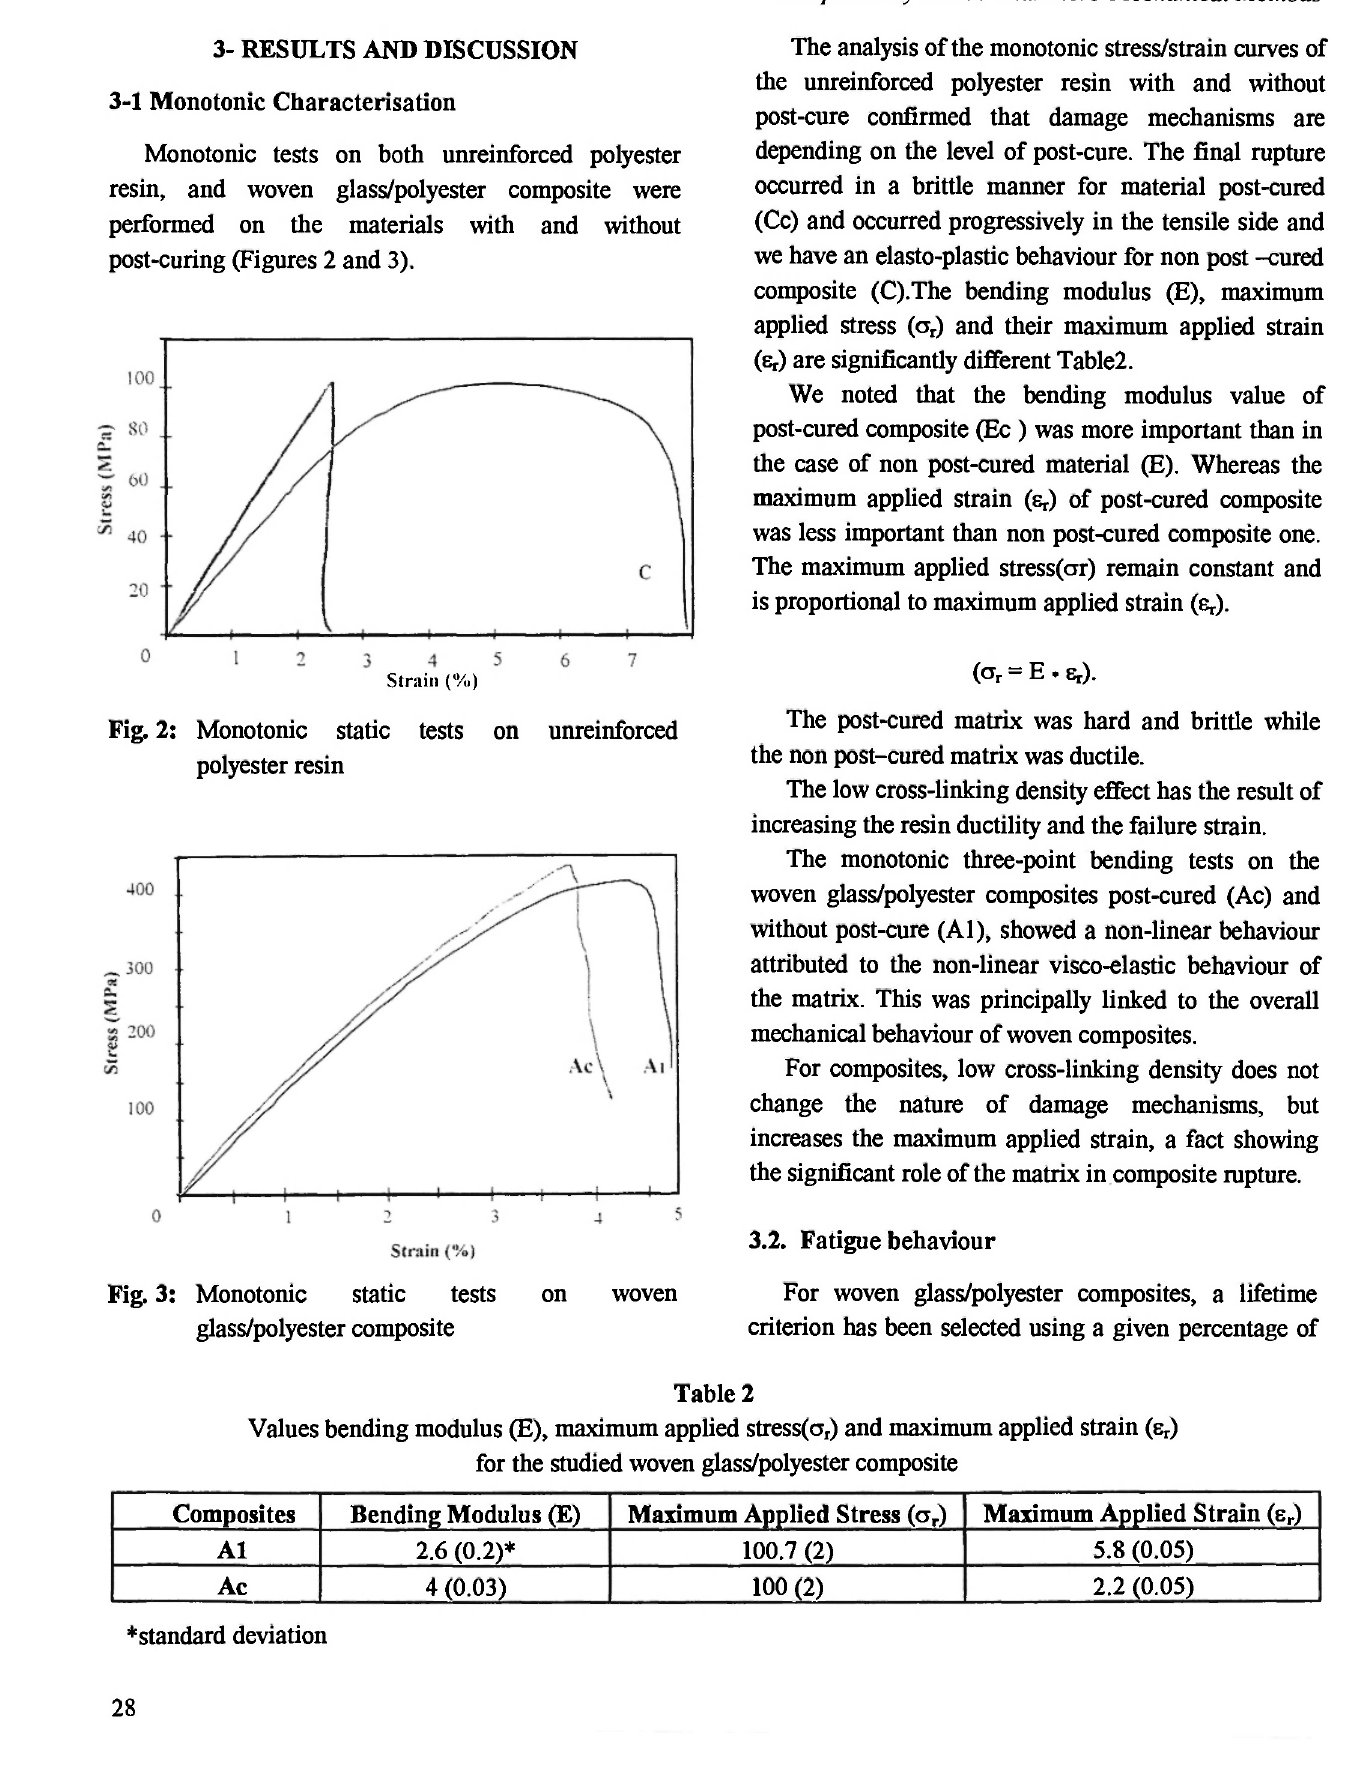
Fig. 3: Monotonie static tests on woven glass/polyester composite